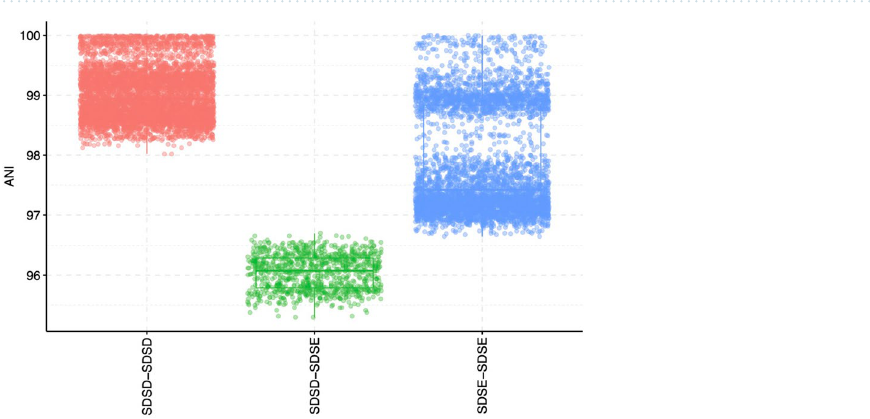
Figure 6. Distribution of pairwise average nucleotide identity within and between the two subspecies of Streptococcus dysgalactiae. SDSD: S. dysgalactiae subsp. dysgalactiae, SDSE: S. dysgalactiae subsp.